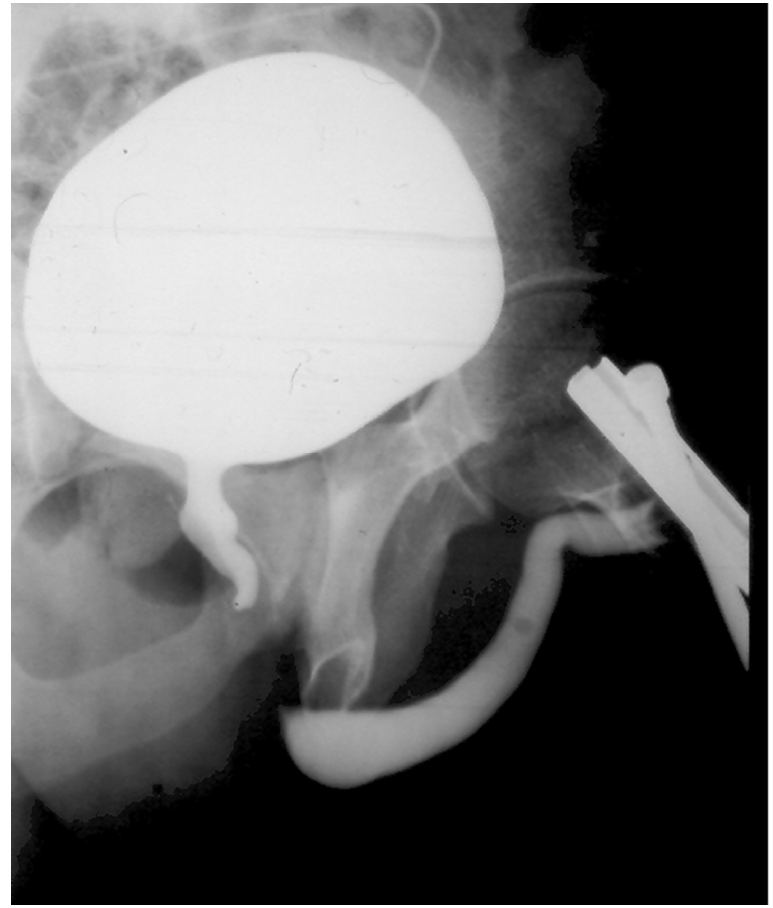
Figure 5. Cystourethrography in a patient with urethral